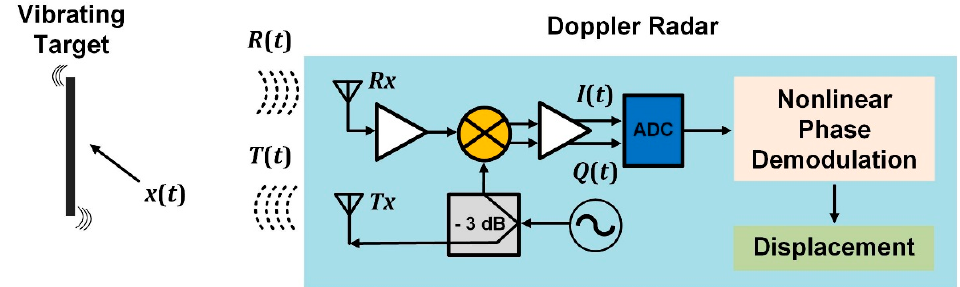
Figure 2. Block diagram for the SHM based on low-cost Doppler radars through remote vibration monitoring.